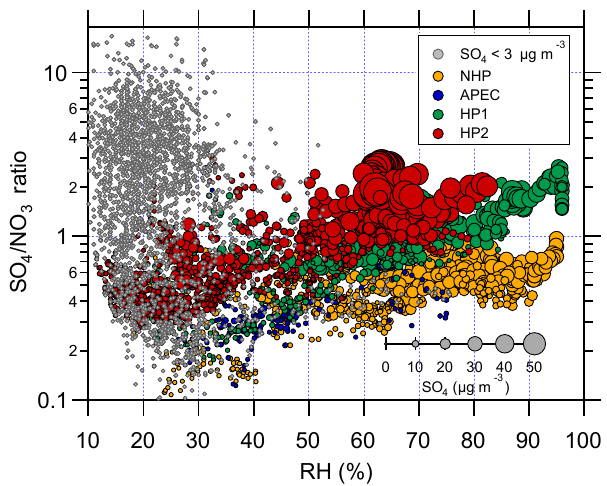
Figure 3. The variations in SO 4 / NO 3 ratios as a function of RH during four different periods, i.e., NHP, APEC, HP1, and HP2. The marker sizes indicate the SO 4 concentrations, and the data points with SO 4 concentrations less than 3µgm − 3 are marked in gray.